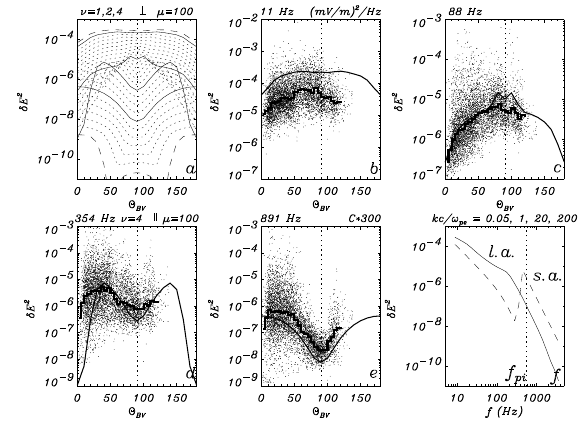
2 ( f, Θ BV ) k ) Figure9:Themodel δE (Eq.4)withasimpleDopplershiftandno k ) Figure8:Themodelsofthewaveve tordistribution I 3 D ( asfun tionsof kc/ω pe 2 isgivenbythe dispersionrelationinEq.3.Thewaveve tordistribution I 3 D ( a)forthemagneti (cid:29)u tuations δB ;inourmodel,theanisotropywithrespe tto µ ompositespe trumofFig.8b.Parametersandobservationsofthe19/12/2001: 2 (Θ BV ) theaverage B (cid:28)elddire tionvarieslike | sin θ kB | with µ ≃ 100;b)fortheele tri 2 Fig. 8. The models of the wave vector distribution I 3 D ( k ) as func- Fig. 9. The model δE 2 (f,2 BV ) (Eq. 4) with a simple Doppler attheSTAFF-SAfrequen ies,from8.8Hz(upperdashed a)themodel δE (cid:29)u tuations δE ;intheele tromagneti range(solidline, kc/ω pe ≃ 0.03to30), µ line)to3600Hz(lowerdashedline).Thefoursolidlines orrespondrespe tively theanisotropymodelvarieslike | sin θ kB | with µ ≃ 100.Intheele trostati range tions of kc/ω pe (a) for the magnetic fluctuations δB 2 ; in our model, shift and no dispersion relation in Eq. (3). The wave vector distri- µ to f =11Hz,88Hz,354Hzand891Hz;arbitraryordinates;b)themodelat (dashedline, kc/ω pe ≃ 16to160),theanisotropymodelvarieslike | cos θ kB | with µ ≃ 11Hz(solidline) omparedtothes atterplotandthemedianoftheobservations the anisotropy with respect to the average B field direction varies bution I 3 D ( k ) is given by the composite spectrum of Fig. 8b. Pa- 100.8 atthesamefrequen y,asafun tionof Θ BV ; )themodelandtheobservationsat 88Hz,d)at354Hz,e)at891Hz;f)themodelspe traforlarge Θ BV angles like | sin θ kB | µ with µ ’ 100; (b) for the electric fluctuations δE 2 ; rameters and observations on 19 December 2001: (a) the model (solidline, l.a. )andforsmall Θ BV angles(dashedline, s.a. ).Theverti aldotted linegivestheaveragevalueof f pi onthe19/12/2001. δE 2 (2 BV ) at the STAFF-SA frequencies, from 8.8Hz (upper in the electromagnetic range (solid line, kc/ω pe ’ 0.03 to 30), the anisotropy model varies like | sin θ kB | µ with µ ’ 100. In the electro- dashed line) to 3600Hz (lower dashed line). The four solid lines static range (dashed line, kc/ω pe ’ 16 to 160), the anisotropy model correspond, respectively, to f =11Hz, 88Hz, 354Hz and 891Hz; varies like | cos θ kB | µ with µ ’ 100. arbitrary ordinates; (b) the model at 11Hz (solid line) compared to the scatter plot and the median of the observations at the same fre- 9 quency, as a function of 2 BV ; (c) the model and the observations at 88Hz, (d) at 354Hz, (e) at 891Hz; (f) the model spectra for large 2 BV angles (solid line, l.a.) and for small 2 BV angles (dashed line, s.a.). The vertical dotted line gives the average value of f pi on 19 December